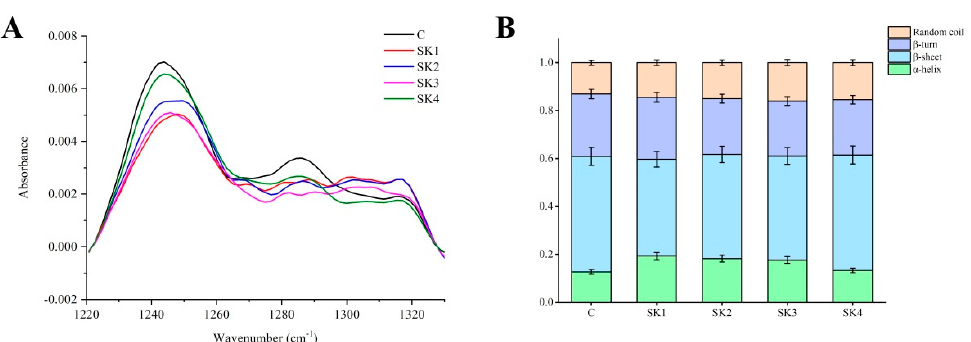
Figure 3. Amides III (1220-1330 cm − 1 ) in FT-IR spectra ( A ) and relative amounts of secondary struc- ture in the surimi gels ithout and with different KEH ( B ). structure in the surimi gels ithout and with different KEH ( B